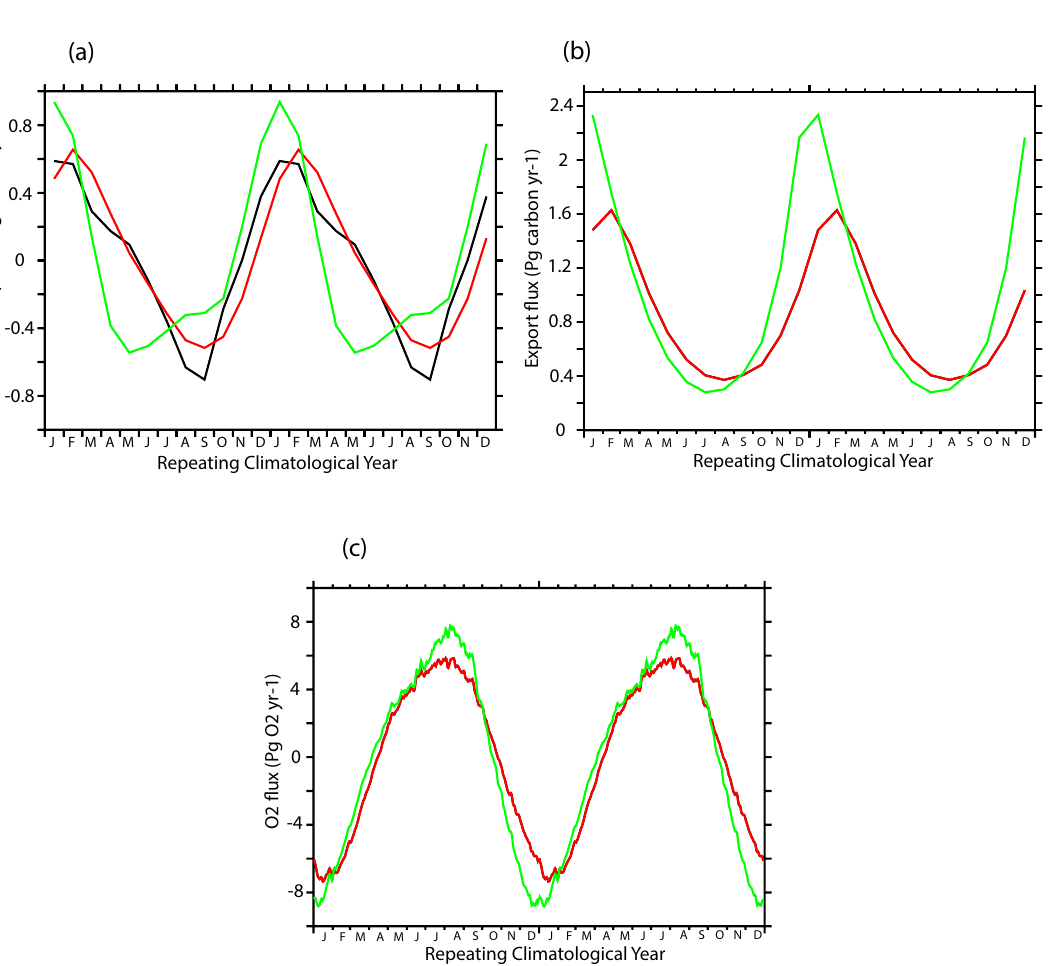
Figure 6. Time variability of Southern Ocean (45–90 ◦ S) fluxes in units of petagrams per year: (a) climatological seasonal cycle of air–sea CO 2 fluxes, for the climatology of Takahashi et al. (2009) using the gas exchange parameterization of Wanninkhof (1992) in black, the WSTIR case in red, and the CNTRL case in green; (b) climatological seasonal cycle of carbon export over the Southern Ocean, showing WSTIR (red) and CNTRL (green); (c) climatological seasonal cycle of air–sea O 2 fluxes, for WSTIR (red) and CNTRL